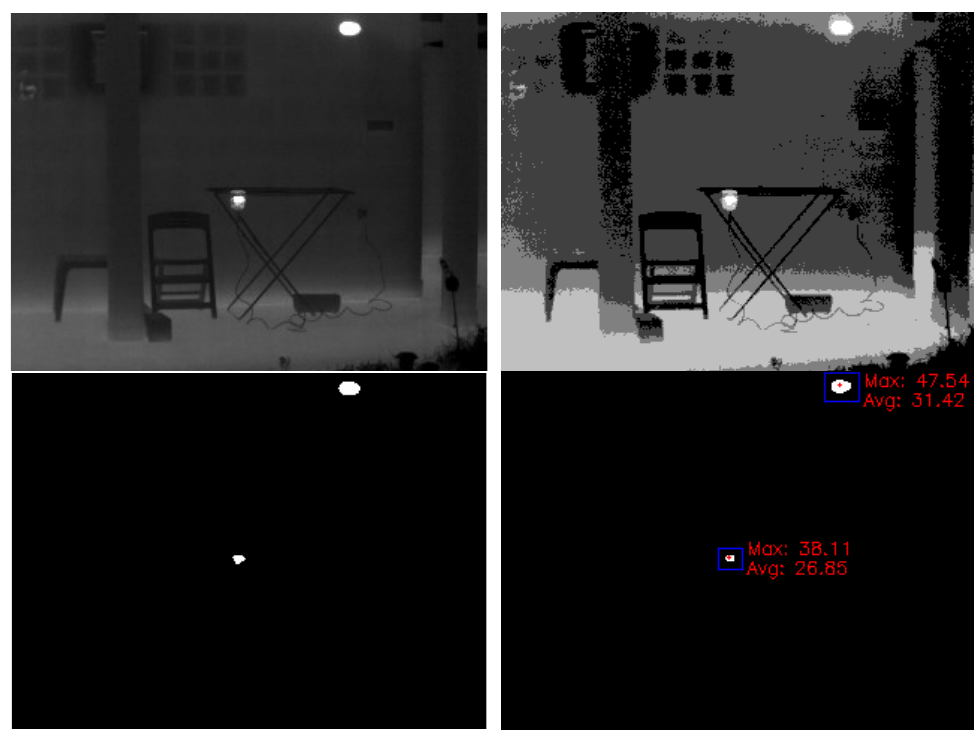
Figure 15. Observed scene ( top-left ), threshold image ( top-right ), detected hotspots ( bottom-left ), and analyzed hotspots ( bottom-right ).